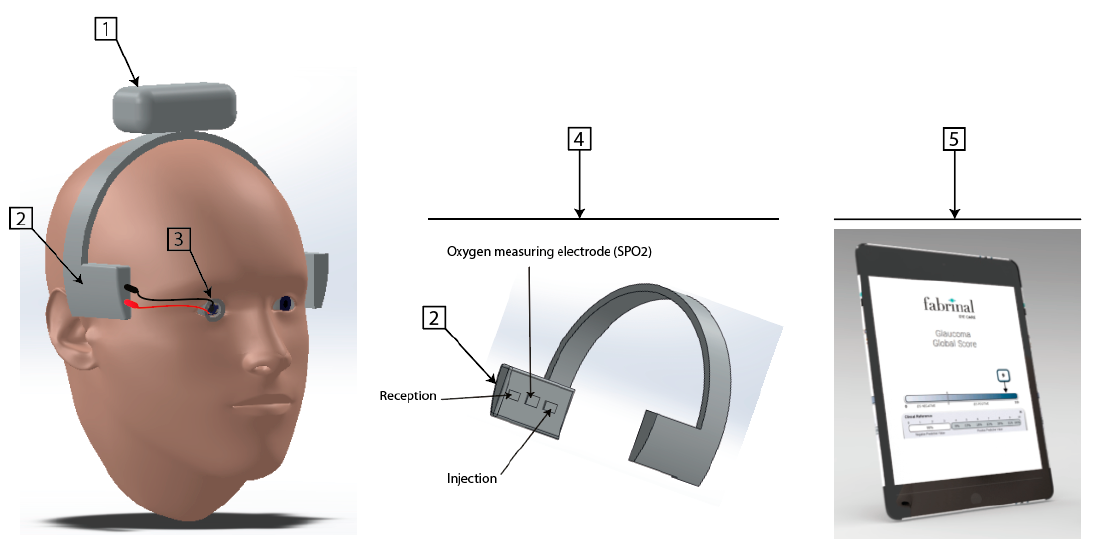
Figure 6. First 3D rendering Impedance Eye Recording (IER).